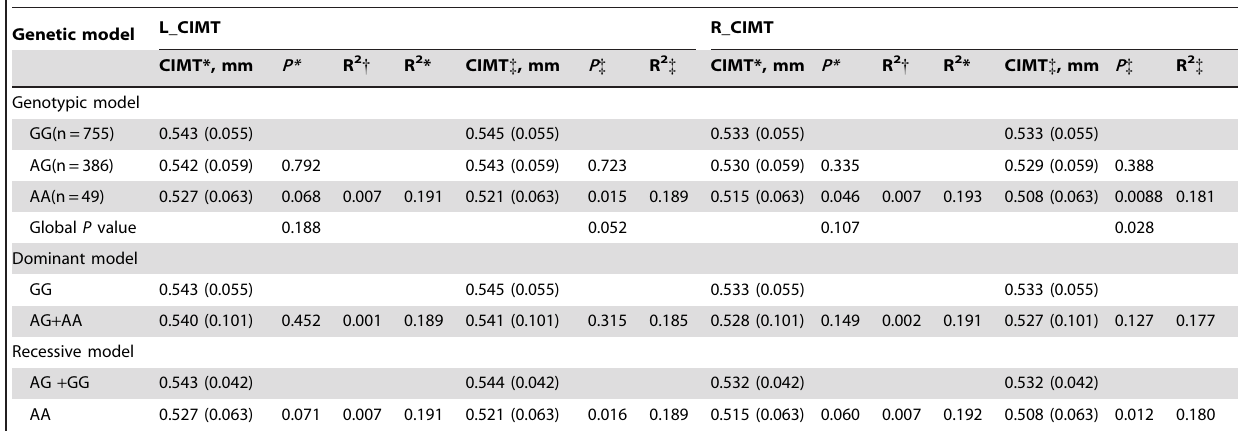
Table 2. Associations of rs2230500 with CIMT.